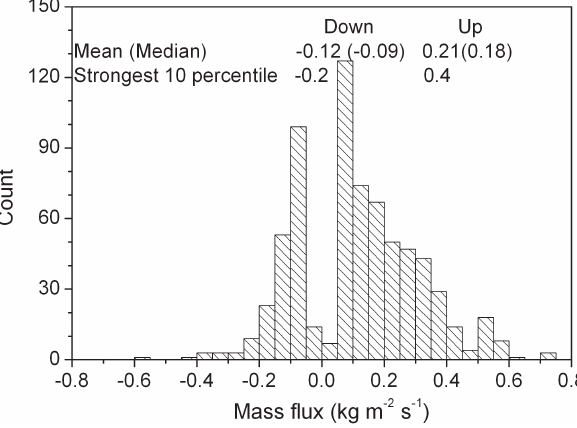
Fig. 5. The distribution for mass flux per unit volume across the